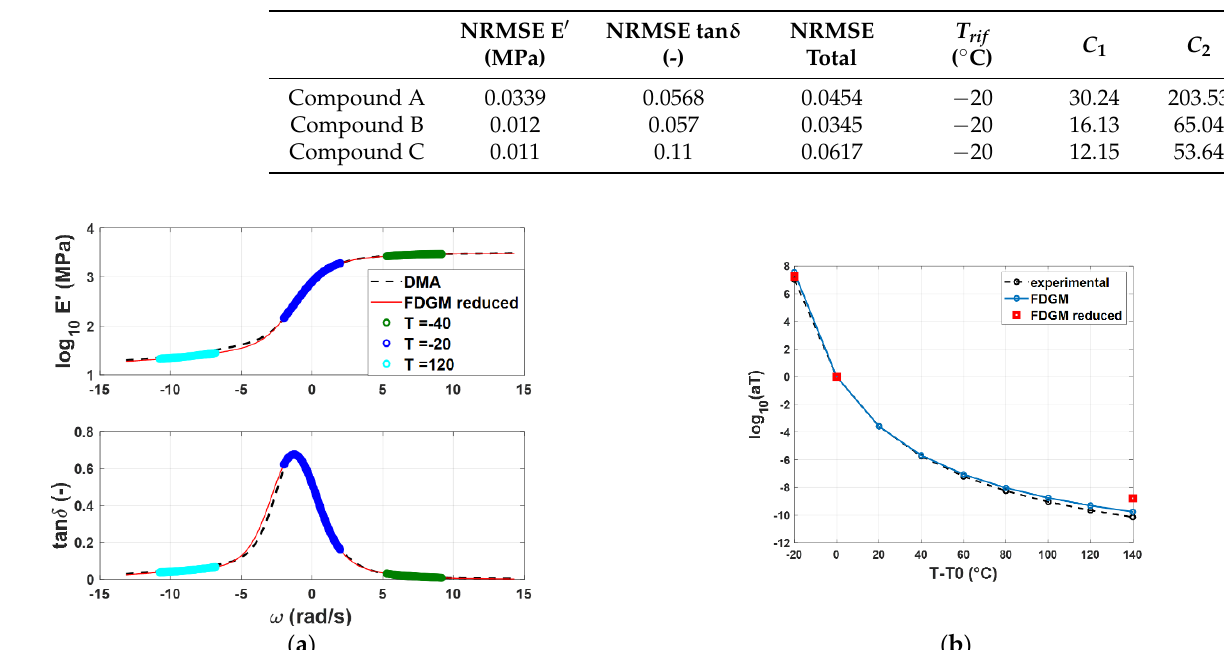
Table 3. NRMSEs and identified WLF coefficients for compounds A, B, and C in case of partial DMA data.